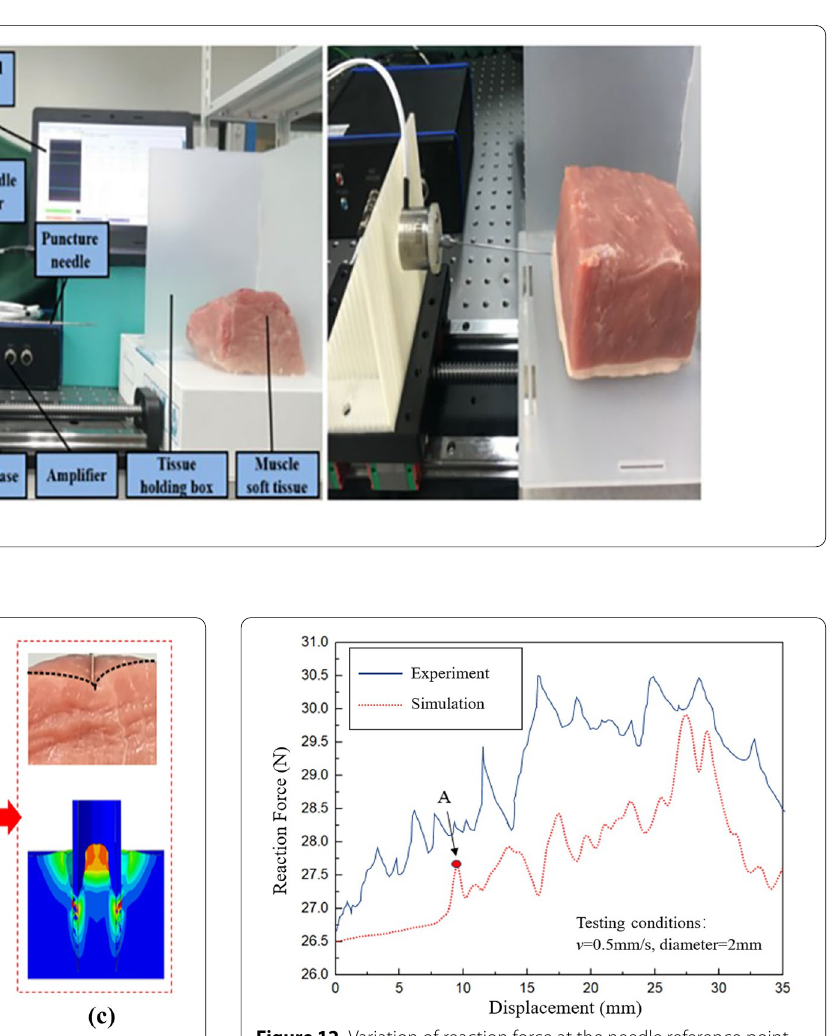
Figure 11 Comparison of puncture experiment and simulation results with different puncture depth